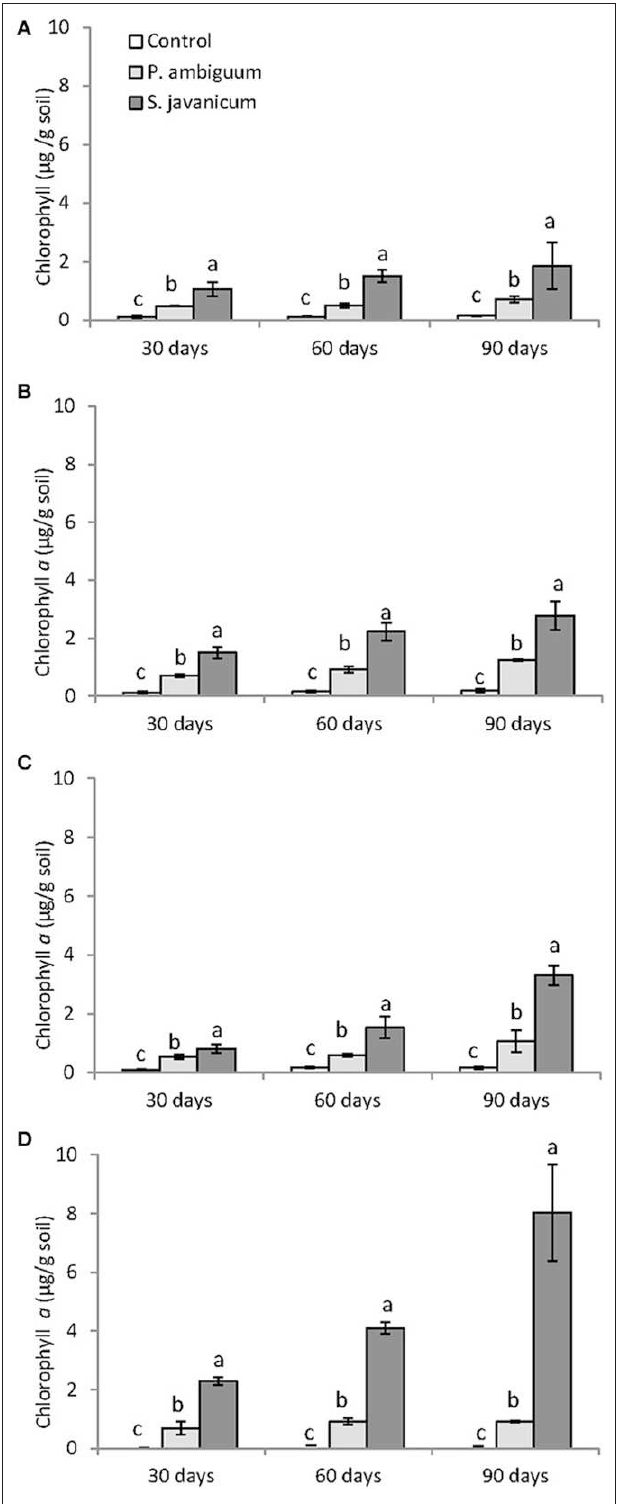
FIGURE 3 | Chlorophyll content in control and inoculated soils after 30, 60, 90 days of incubation in the different soil types: silt loam (A) , sandy loam (B) , loamy sand (C) , and sandy (D) . Different letters indicate significant differences among cyanobacteria